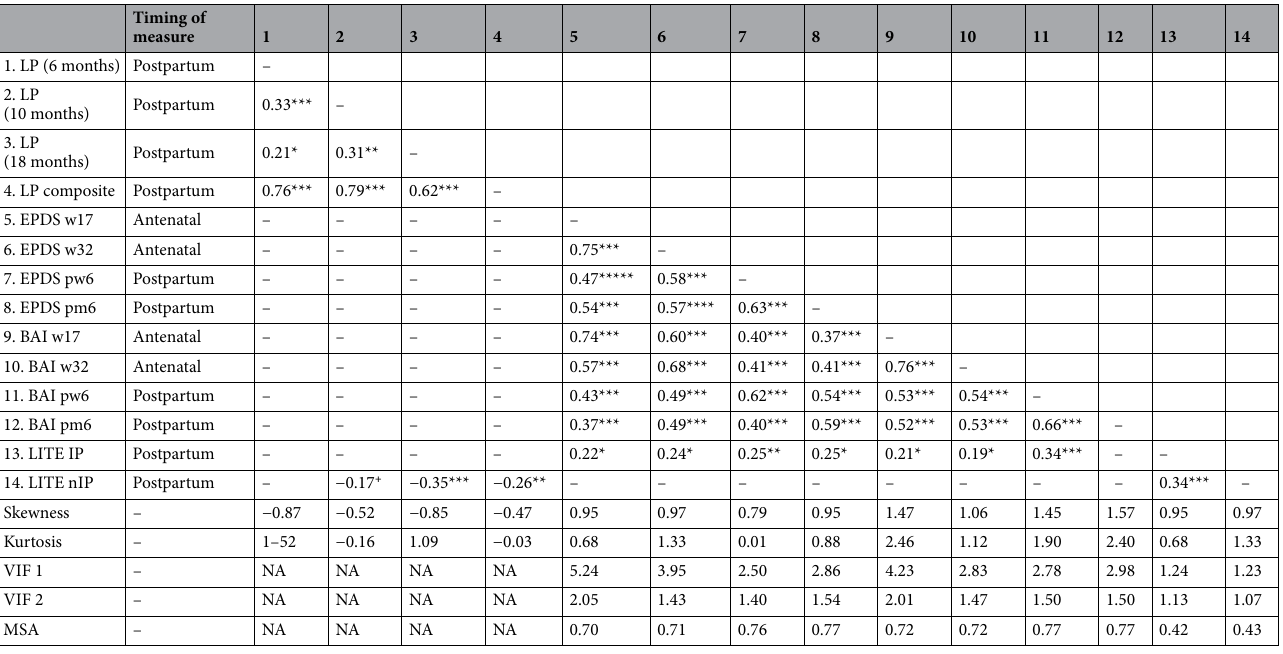
Table 4. Pearson’s zero order correlations between all variables using raw scores. + p < 0.1, * p < 0.05, ** p < 0.01, *** p < 0 .001 with Benjamini–Hochberg correction. Abbreviations: LP, look percentage; LP composite, mean look percentage of three age points; EPDS, Edinburgh Postnatal Depression Scale; BAI, Beck Anxiety Inventory; LITE, Lifetime Incidence of Traumatic Events; VIF, variance inflation factor (using LP as an outcome, other 10 variables as predictors; VIF 1 is calculated all with raw scores; VIF 2 is calculated with factor scores of EPDS and BAI and composite scores of LITE); MSA, measure of sampling adequacy according to Kaiser–Meyer–Olkin test; w17, pregnancy week 17; w32, pregnancy week 32; pv6, postpartum 6 weeks; pm6, postpartum 6 months; IP, interpersonal events; nIP, non-interpersonal events; NA: not applicable, as LP 6, 10, and 18 months were used as dependent